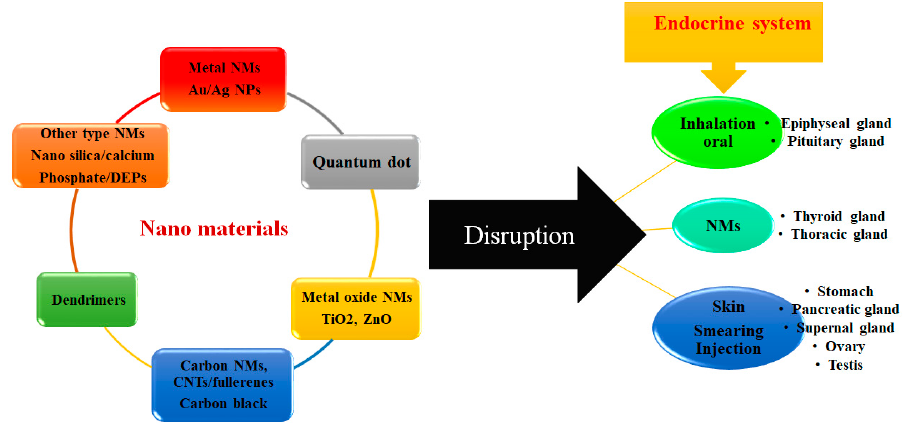
Figure 5. Toxic effects of diverse types of nanoparticles on various organs.